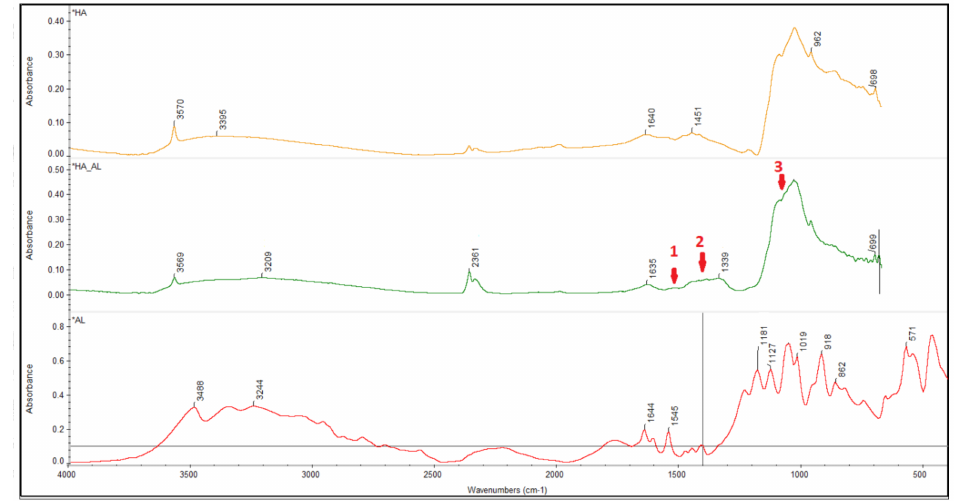
Figure 3. FTIR Reflection Spectra of MAPLE deposited HA-AL compound (green) versus pure HA (orange) and pure AL